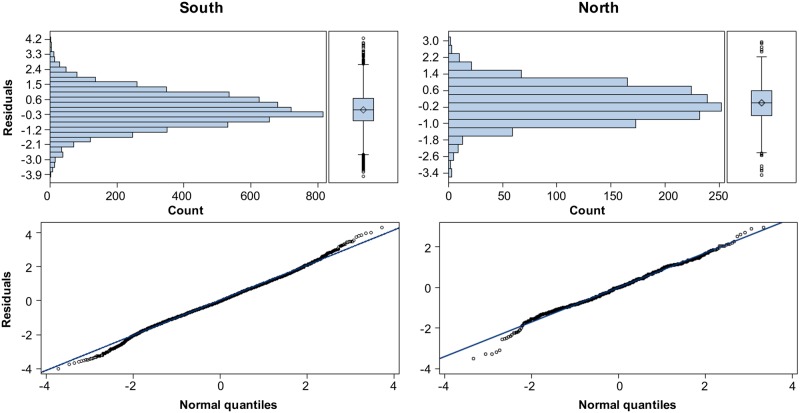
Diagnostic residual plots.The plots are for the GLM runs with a delta-lognormal assumption for the standardization of the PBF CPUE for the southern (left) and northern (right) fishing grounds. The KS two-sample tests indicate that both residual distributions do not significantly differ from the normal distribution assumption (p > 0.10).